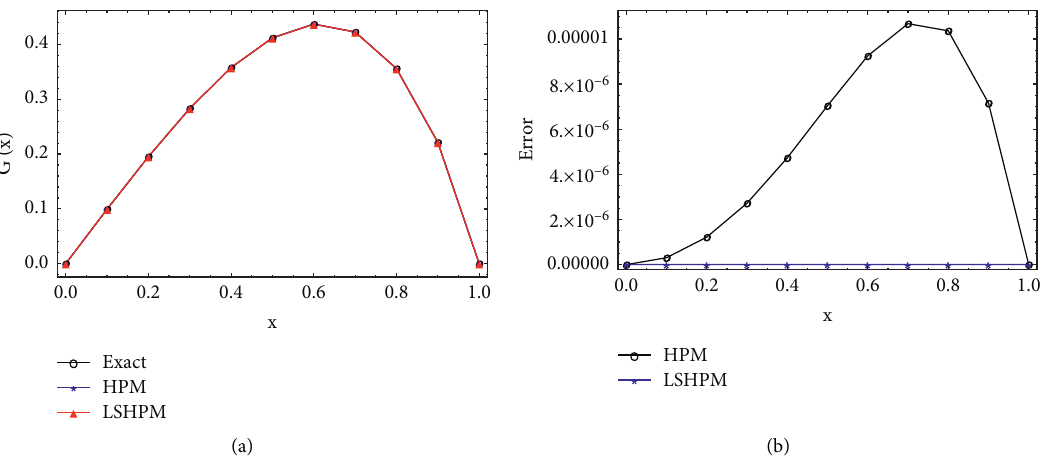
Figure 3: Graphical representation of solutions and errors in Problem 3. (a) Comparison of Exact, HPM, and LSHPM Solutions. (b) Comparison of absolute errors of HPM and